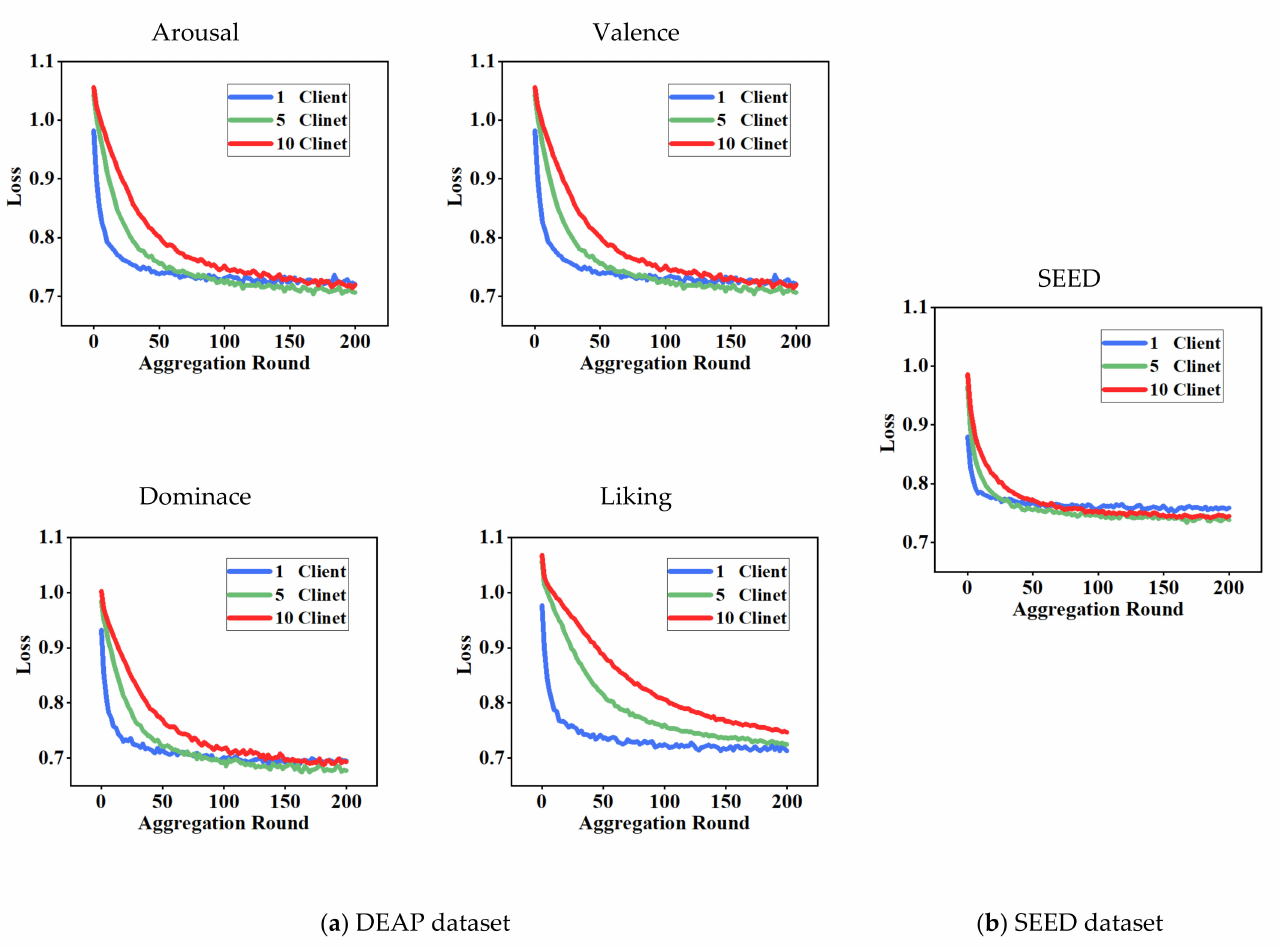
Figure 3. The loss decreases curve of different numbers of clients during training on the four emotions of DEAP dataset ( a ) and SEED dataset ( b ). The ordinate is the loss value, and the abscissa is the aggregation